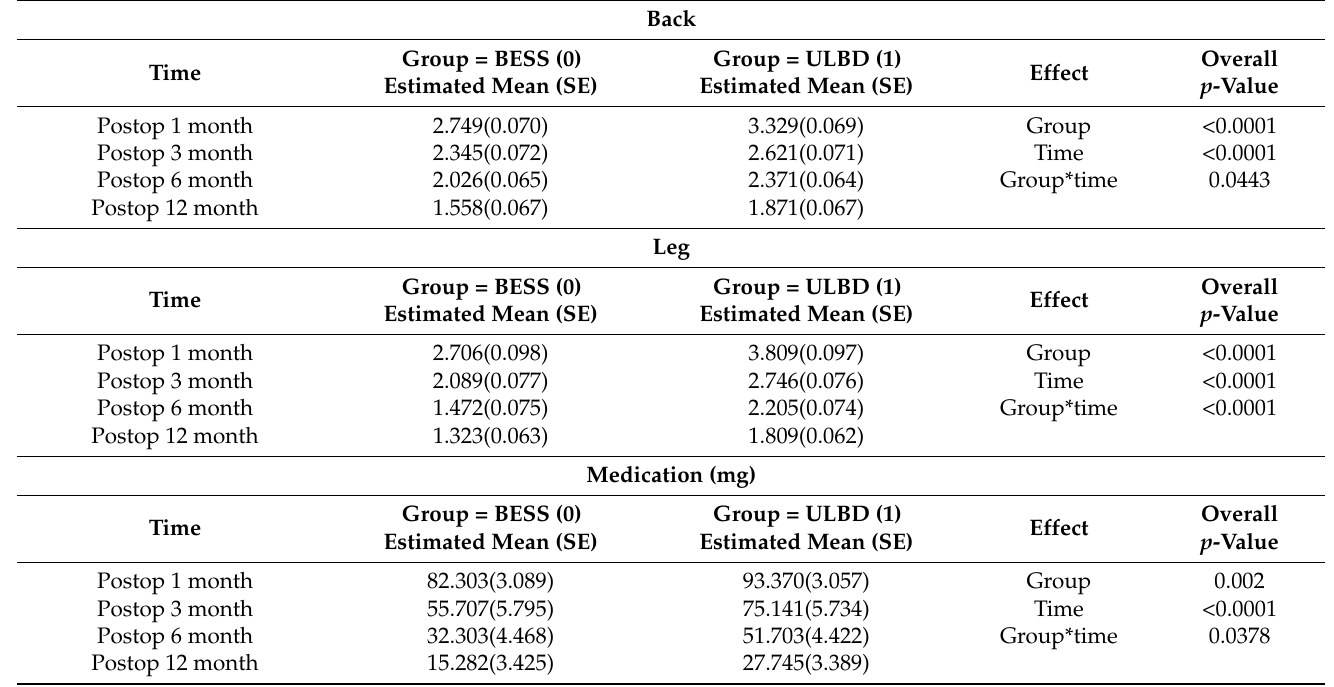
Table 4. Clinical outcomes—VAS score and medication use by range of levels.